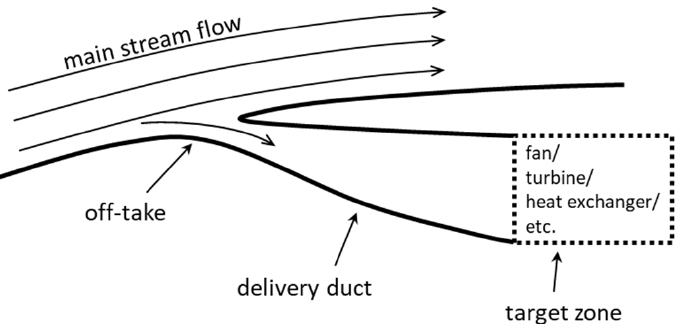
Figure 1. Generic off-take and delivery duct.